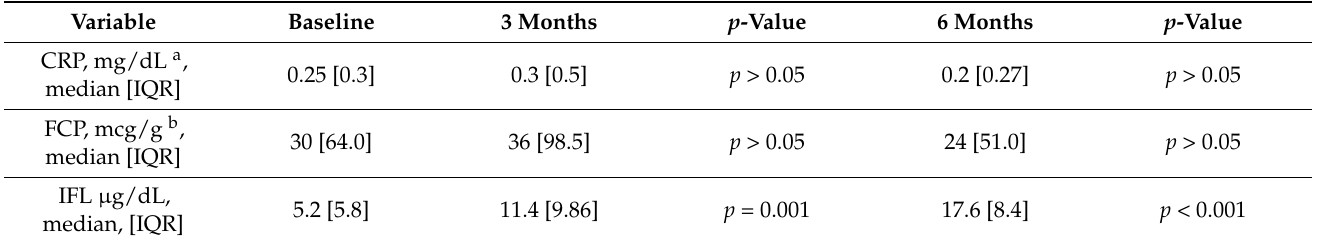
Table 2. Trends in biomarkers and infliximab trough levels in standard regimen patients.